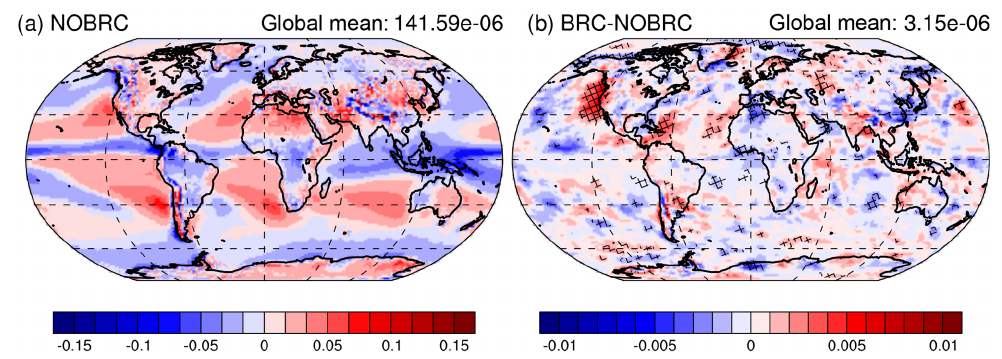
Figure 12. 500mb ω in Pas − 1 from the BRC model run: (a) the default annual average and (b) the difference with the incorporation of BrC. Hatching indicates significance in the ensemble year change to the 0.1 level. Table 3. Different RE contributions globally, in the tropics (25 ◦ S to 25 ◦ N), and in the Arctic (60 ◦ N to 90 ◦ N) from BRC, BRC_CNST, and BRC_BL model runs. These values are from a 9-year period, 2003–2011. Standard deviations from the five-ensemble means are included. BrC RE BRC BRC_CNST BRC_BL Global Aerosol–radiation interaction (REari; Wm − 2 ) 0 . 13 ± 0 . 01 0 . 13 ± 0 . 01 0 . 06 ± 0 . 008 Aerosol–cloud interaction (REaci; Wm − 2 ) 0 . 01 ± 0 . 04 Tropics (25 ◦ S to 25 ◦